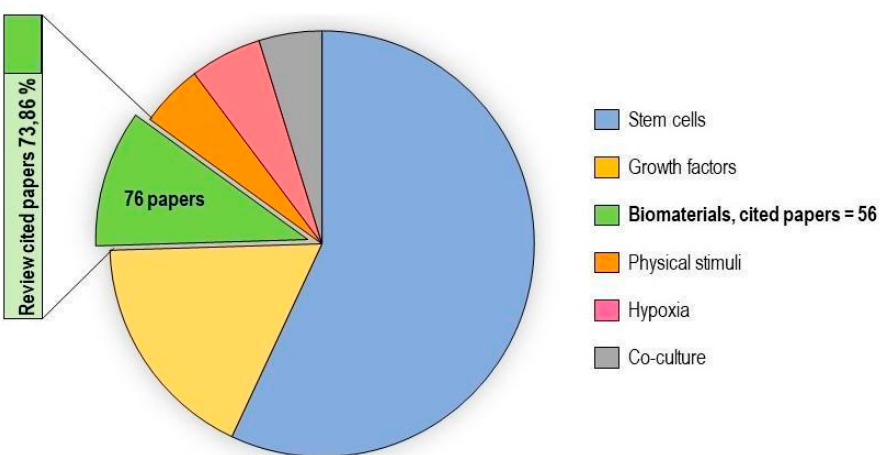
Figure 9. The green section shows the percentage / number of papers available on the Scopus database obtained by combining key words in vitro stem cells tendon differentiation with biomaterials. In the histogram, the relative percentage of cited papers is expressed as well as the relative number in the legend.